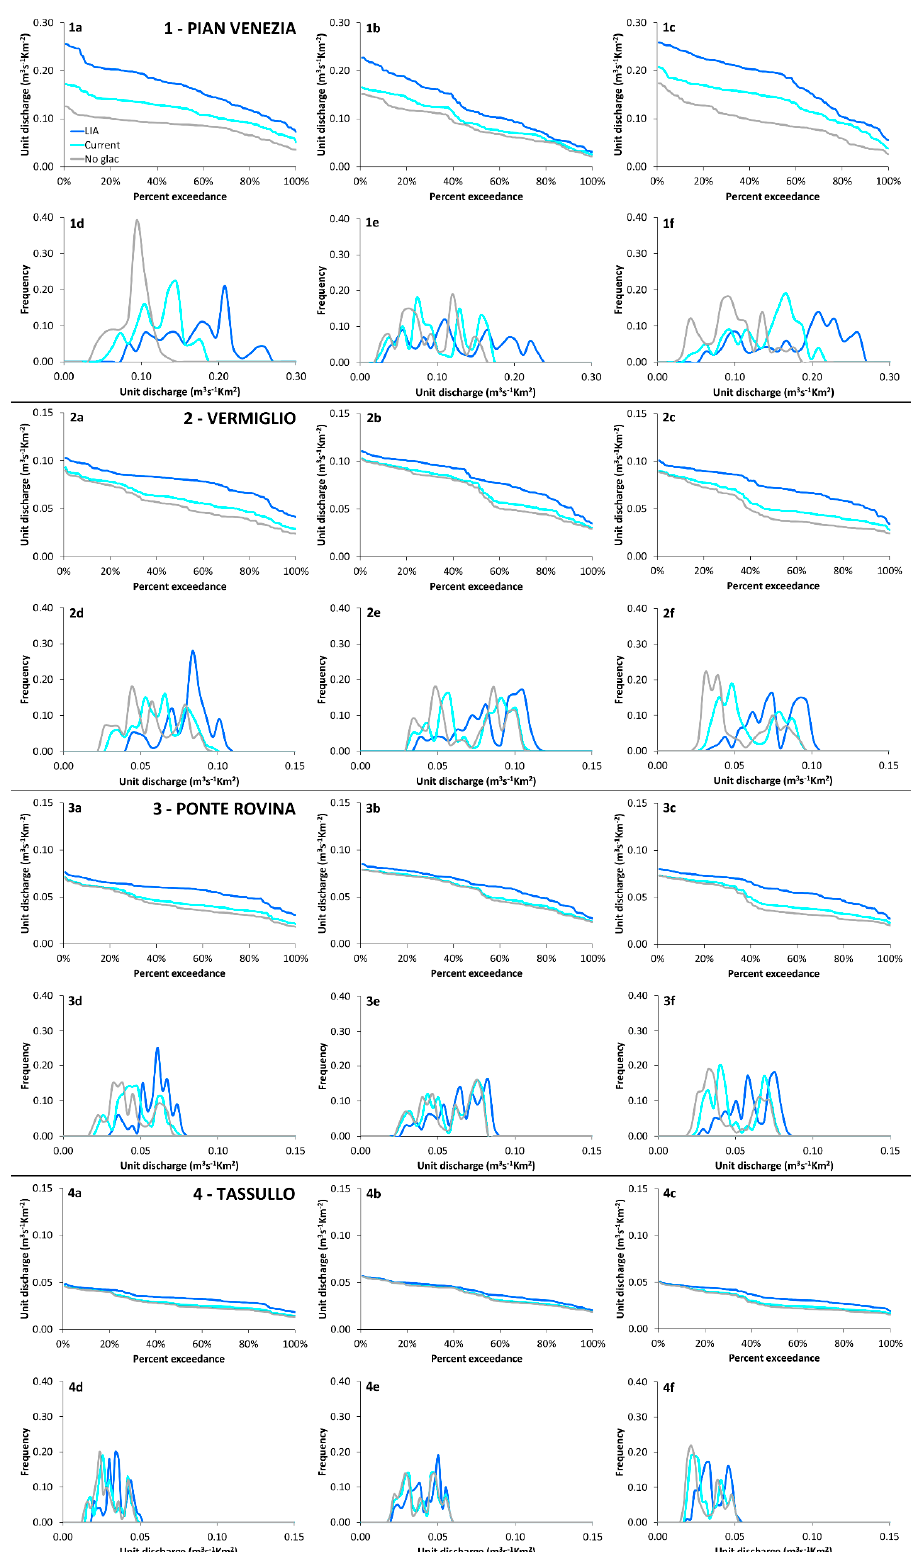
Figure 6. ( a – c ): 10-year averaged flow-duration curves of daily mean unit discharge from April to November in the four investigated catchments; ( d – f ): frequency distribution of the 10-year daily mean unit discharge. Please, note that the vertical axis at Pian Venezia is different from the other three catchments.